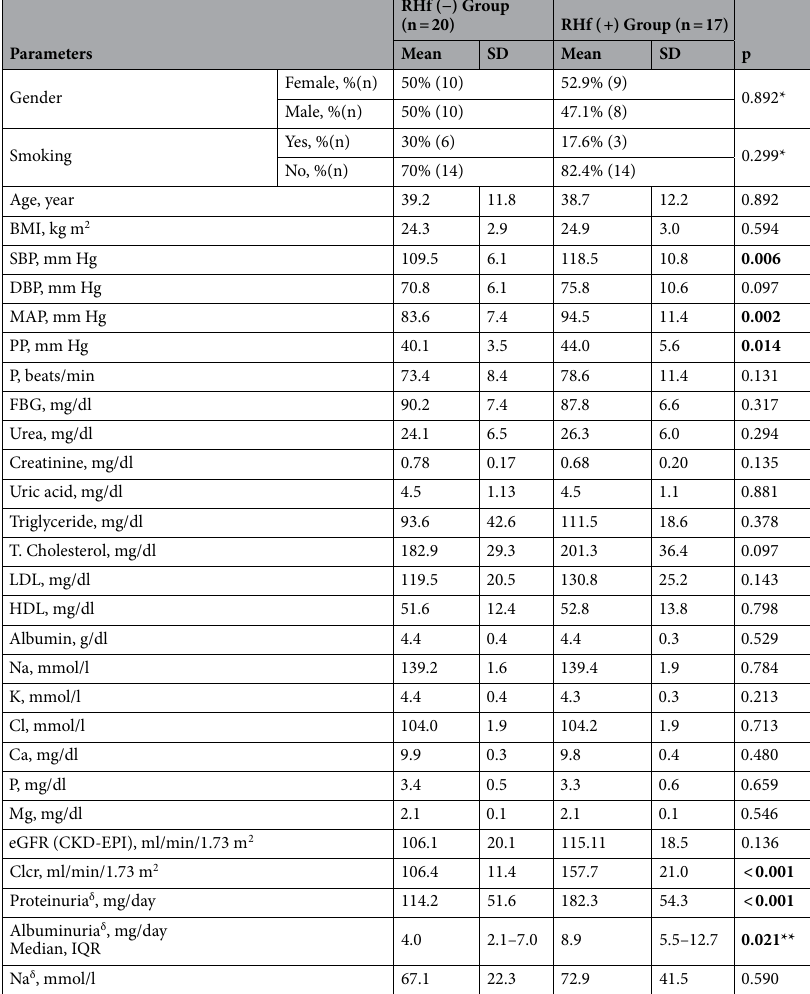
Table 1. Demographic, clinical, and laboratory data of the participants; RHf (−) and RHf (+) groups. Significant values are in [bold]. Student T test, *Chi square test, **Mann Whitney U test, δ 24-h urine data; p < 0.05 is considered significant. SD, standard deviation; BMI, body mass index; SBP, systolic blood pressure; DP, diastolic blood pressure; MAP, mean arterial pressure; PP, pulse pressure; P, pulse; FBG, fasting blood glucose; Clcr, creatinine clearance; eGFR, estimated glomerular filtration rate; CKD-EPI, Chronic Kidney Disease Epidemiology Collaboration Study